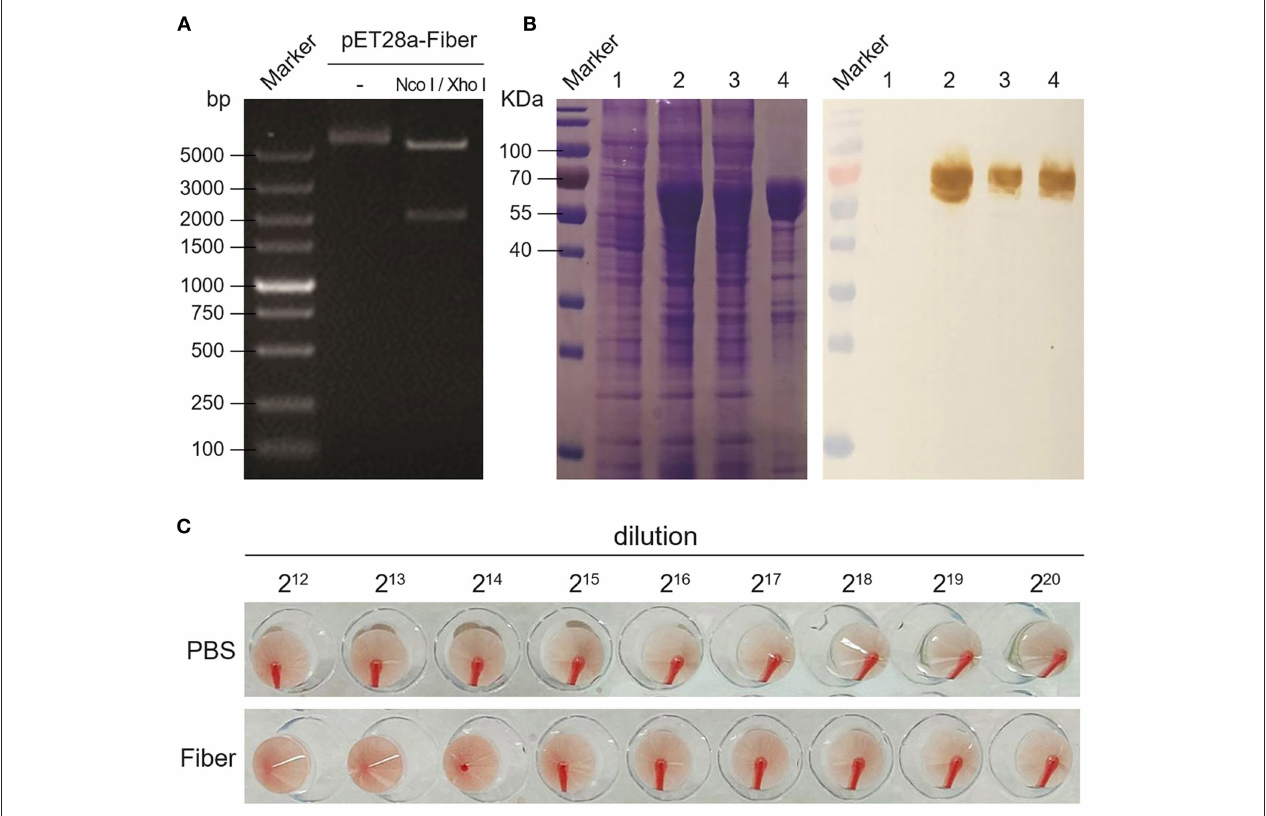
FIGURE 1 | Expression and HA activity of DAdV-1 fiber protein. (A) Double restriction enzyme digestion of recombinant pET28a-fiber plasmid. (B) Expression and identification of fiber protein by SDS-PAGE and Western blot. Lane 1: bacteria without IPTG induction; lane 2: bacteria with IPTG induction; lane 3: supernatant of induced bacteria; lane 4: inclusion bodies of induced bacteria. Positive serum against DAdV-1 AV127 was used as primary antibody in Western blot. (C) HA activity test of fiber protein.